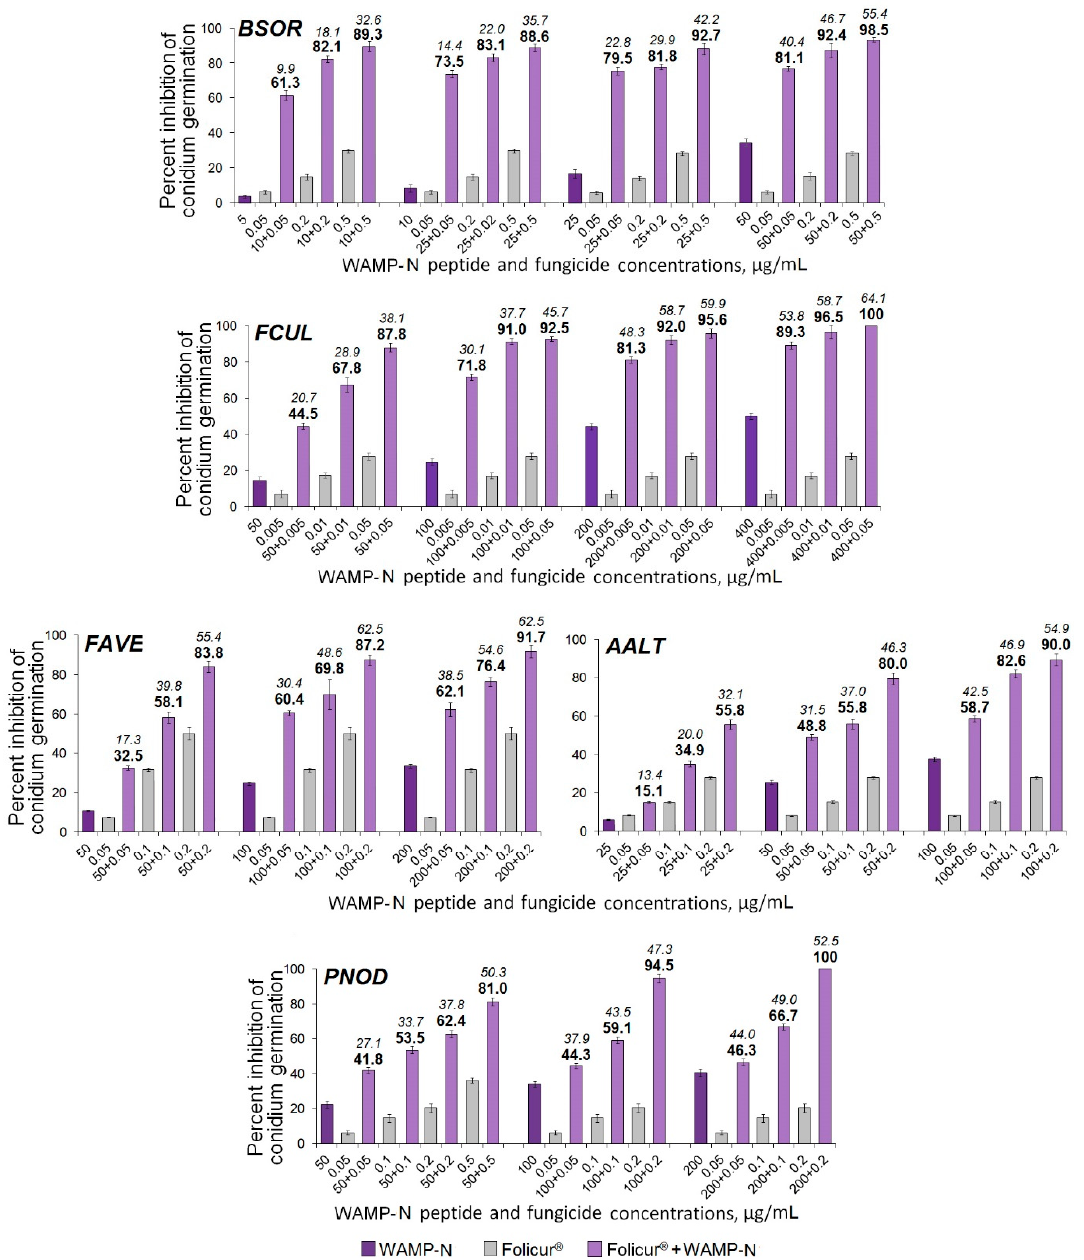
Figure 6. Histograms showing the augmentation of Folicur ® EC 250 inhibitory e ff ect on spore germination of five cereal-damaging fungi due to synergistic interactions of WAMP-N with tebuconazole at di ff erent concentration combinations of the compounds. BSOR , FCUL , FAVE , AALT , and PNOD are B. sorokiniana , F.culmorum , F. avenaceum , A. alternata , and P. nodorum , respectively. The numbers in bold above the columns indicate Er values, while italic numbers show Ee values related to the same fungicide / peptide concentration combination. Er shows percent inhibition of conidian germination when the fungicide and WAMP-N were co-applied; Ee is percent inhibition calculated for an estimated additive e ff ect of the compounds. Er > Ee at p ≤ 0.05 points to synergistic interaction of the compounds (see Materials and Methods, 4.7 and [49]). Results are expressed as the mean of two experiments for each pathogen; Y-bars indicate standard error (SE) of the mean (n = 500 conidia in each individual or combined application).